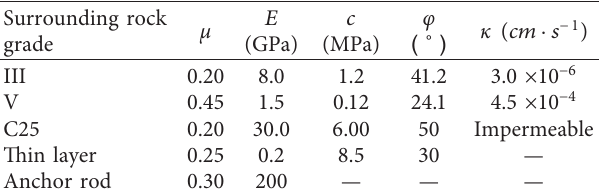
Figure 1: Rock strata crossed by the Laomushan Tunnel: (a) cross section and (b) profile. Table 1: Index values of the physical and mechanical properties of the surrounding rock at all 0.4